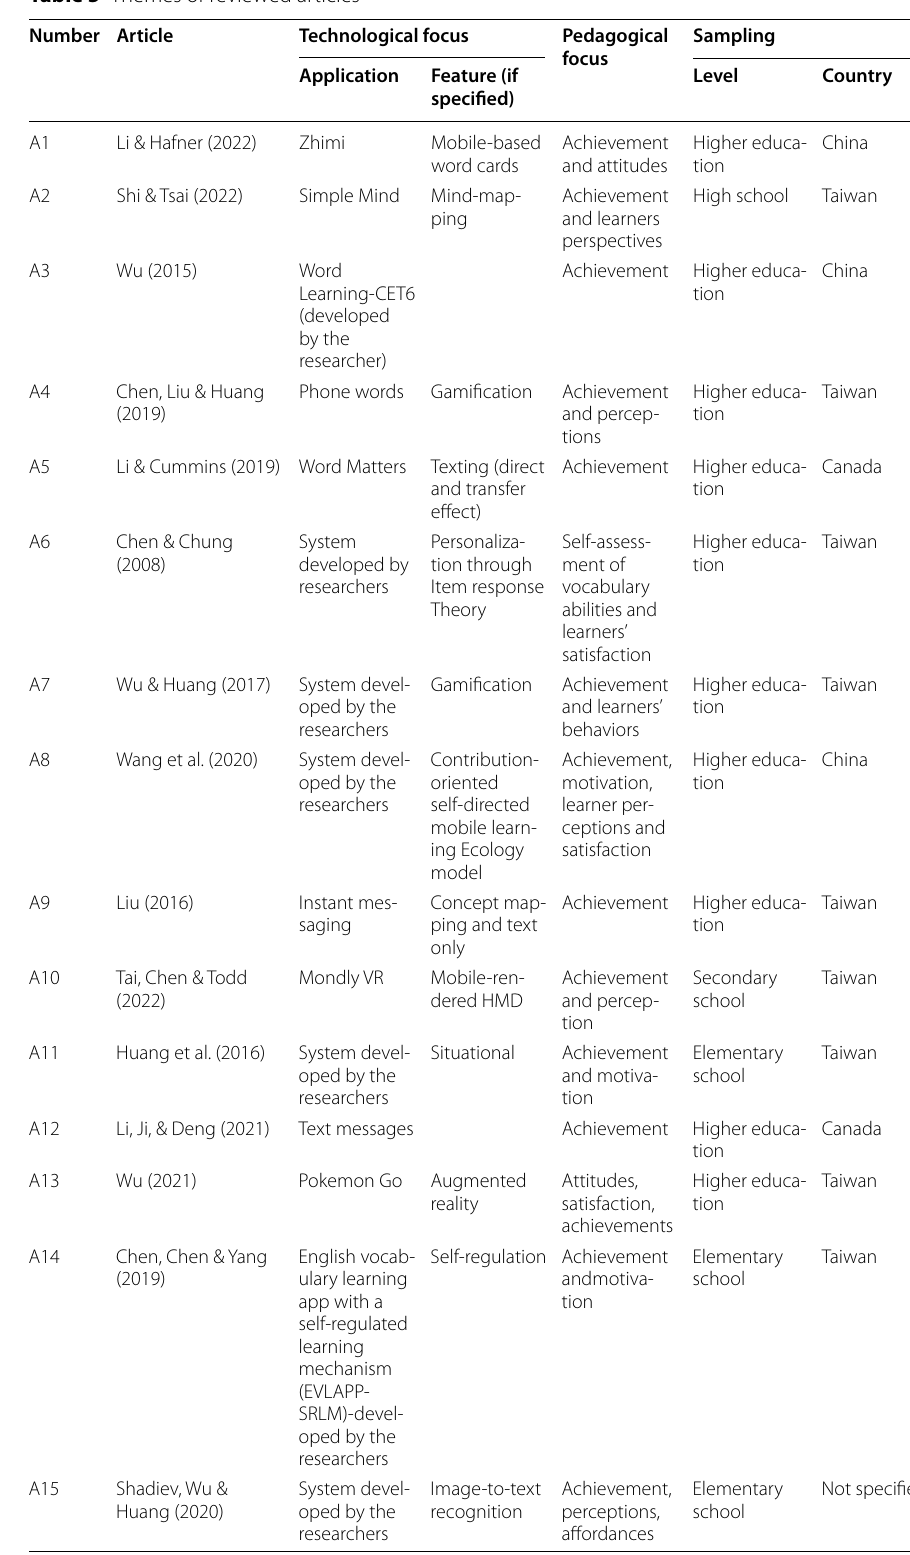
Table 5 Themes of reviewed